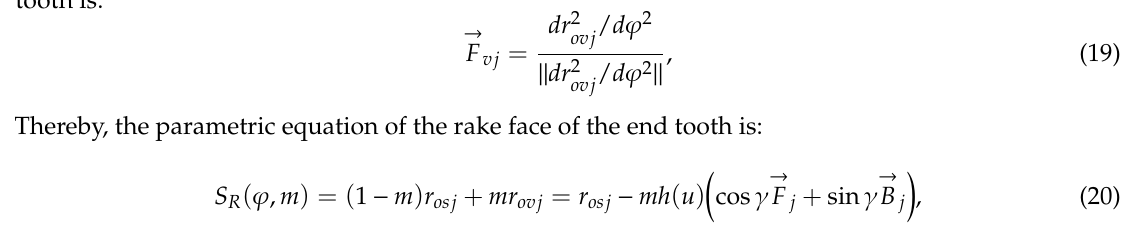
Figure 9. Grinding and geometrical angle detection of revolving cycloid milling cutter: ( a )